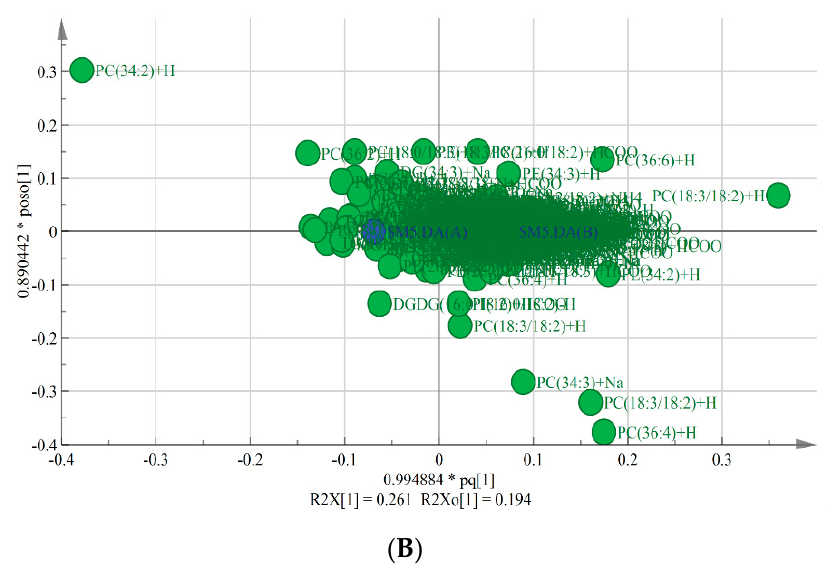
Figure 1. Score plot ( A ) and loading scatter plot ( B ) of OPLS-DA model. Green dots represent banana fruit stored for 0 d, and the blue dots represent banana fruit stored for 4 days at 6 ◦